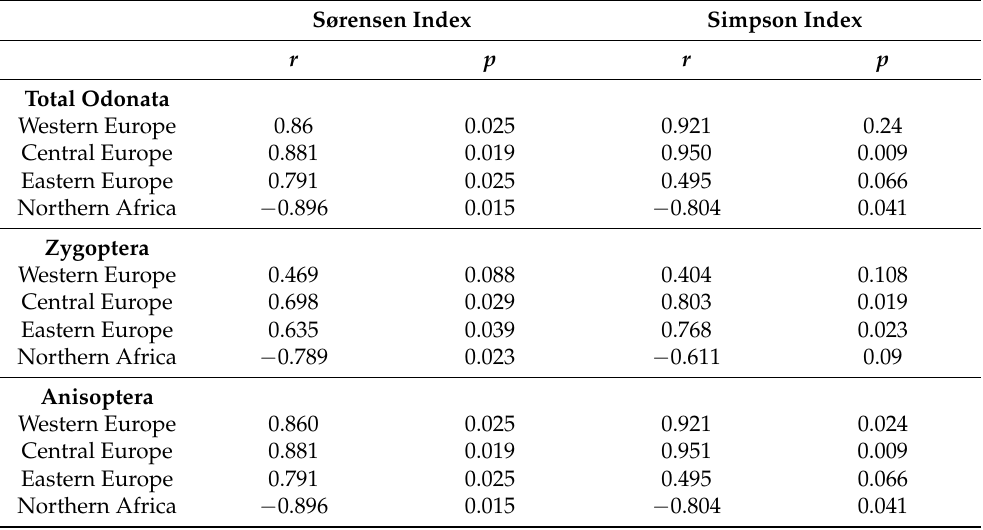
Table 3. Correlation between biogeographical similarity (the Sørensen and Simpson indices) and lati- tude for species living also in Western Europe, Central Europe, Eastern Europe, and Northern